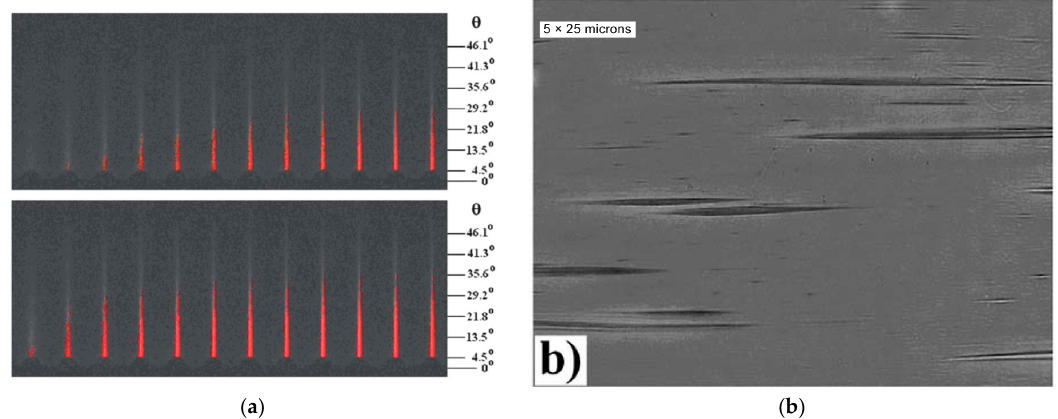
Figure 18. ( a ) Light scattering patterns at 5 s intervals after field onset for 20 kA/m (top) and 40 kA/m (bottom) and ( b ) Optical microscopy image of magnetically induced spindle like aggregates (the scale bar is 25 microns). Reprinted with permission from Reference [35].